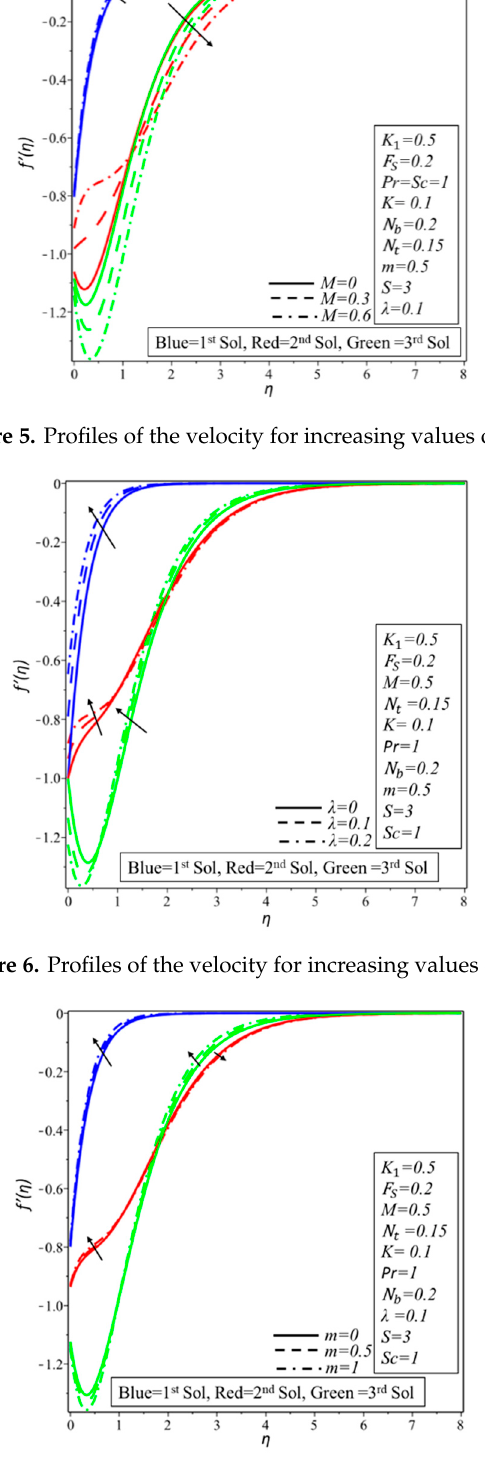
Figure 7. Profiles of the velocity for increasing values of m .